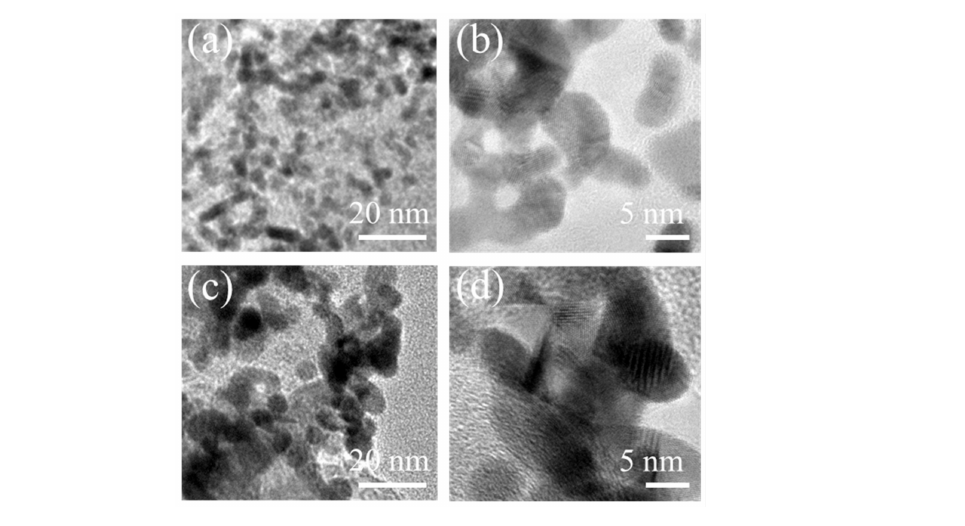
Figure 8. TEM images of cathode Pt/C catalyst before ( a , b ) and after ( c , d ) the 64 h test at a current density of 80 mA cm − 2 .